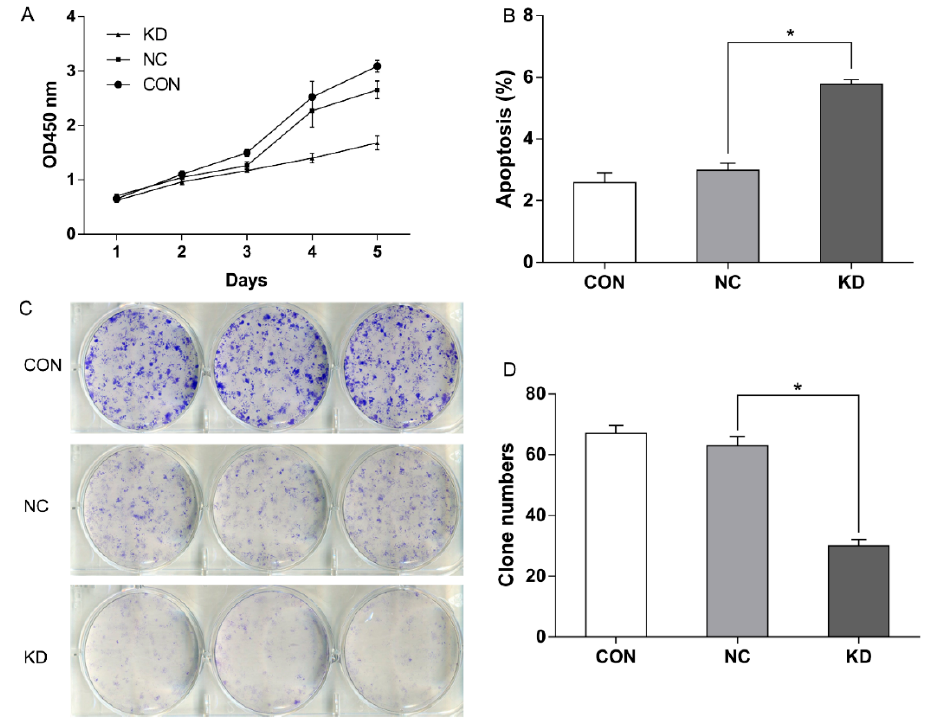
Figure 3. EBLN1 silencing affects the proliferation, apoptosis, and colony formation of OL cells. ( A ) Growth curves of OL cells in 3 different groups, as measured by the CCK-8; ( B ) EBLN1 gene silencing induced marked apoptosis in OL cells. ( C + D ) EBLN1 gene silencing inhibited colony formation with OL cells. CON, uninfected group; NC, LV-NC-shRNA group; KD, LV-EBLN1-shRNA group. * p < 0.01.